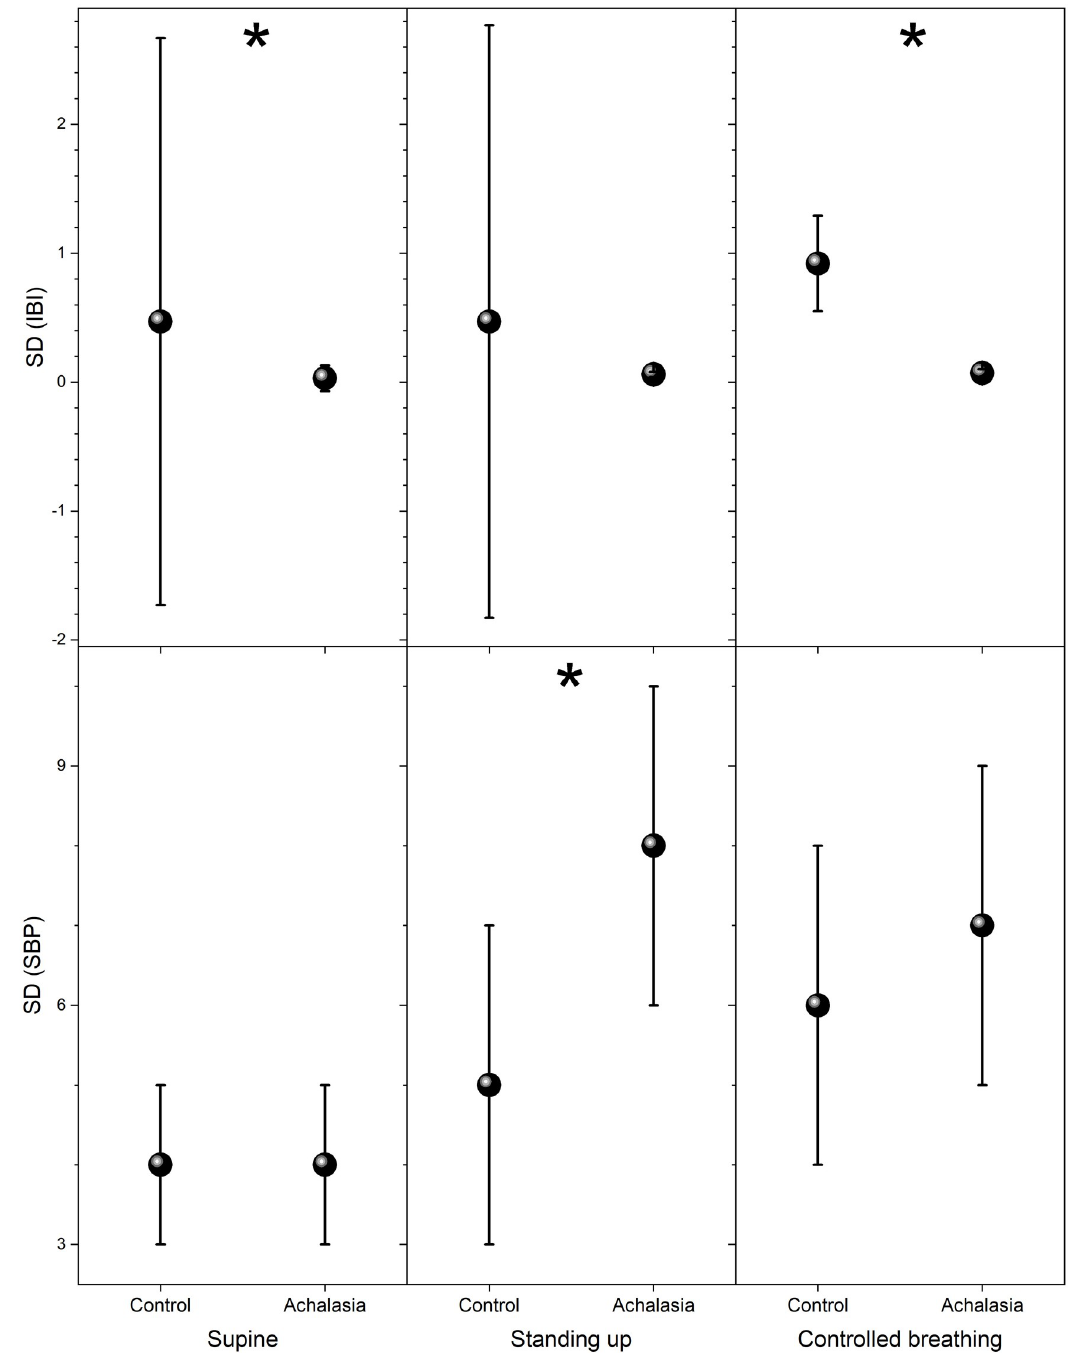
Fig 4. Standard deviation of detrended data for the different groups for IBI (upper panels) and SBP (bottom panels) during supine position (left-hand panels), standing up (middle panels), and controlled breathing (right-hand panels). The vertical crosshair corresponds to one standard deviation around the population average, while the dot is the median; � indicates statistically significant difference with respect to control ( p value < 0.05).